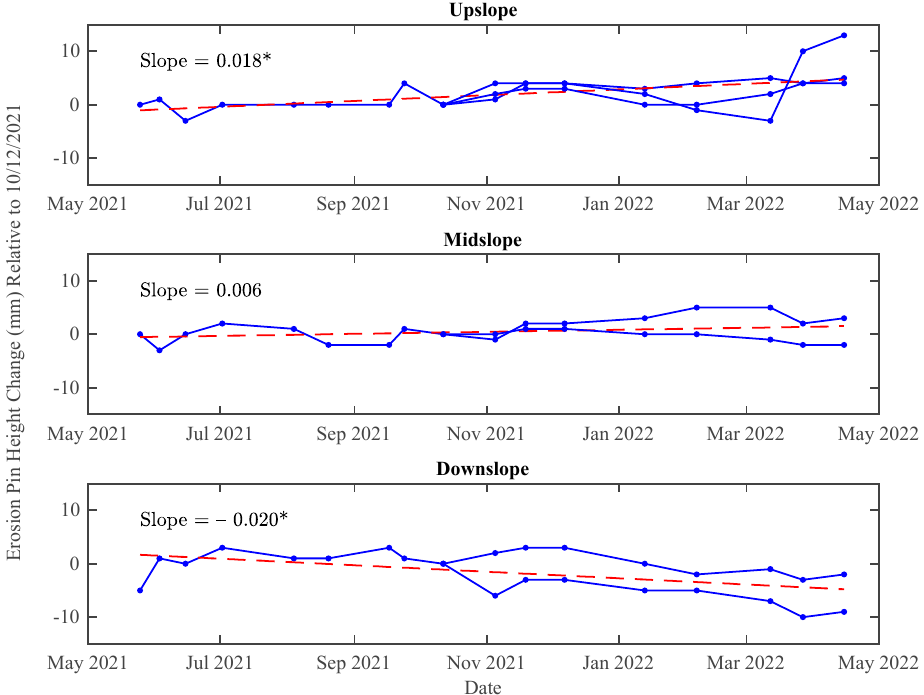
Figure 7. Linear regression for the plot with juniper between time in days and erosion pin height relative to the measurement on 12 October 2021, when all erosion pins were installed and stabilized. Solid blue lines and markers show the trajectory of measurements for each erosion pin and dashed red lines show the regression line. Regression slope is given in each plot with * indicating a regression p -value less than 0.1. Regression lines are calculated separately for upslope ( top ), midslope ( middle ), and downslope ( bottom ).